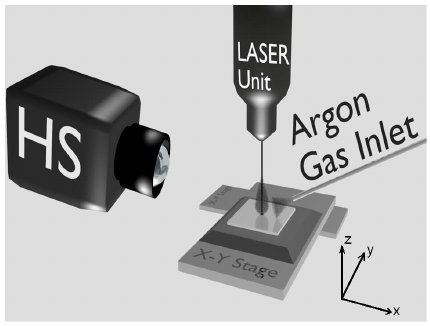
Figure 1. Schematic of experimental set-up for laser welding and monitoring. HS: High-speed camera. In order to protect the weld pool against oxidation, high-purity Argon (Ar, 99.9999%) was used as shielding gas. The Ar gas was delivered through a 4 mm diameter polytetrafluoroethylene (PTFE) tubing placed in the xz plane, at 3 cm from the laser spot at an angle of approximately 50° in respect to the sample surface, while the sample was translated along the y direction (see Figure 1 for movement reference). An optimized Ar flow rate of 5 L/min was used for preventing oxidation. Thus, an Ar content of 99% was measured 1 cm ahead of the welding site by mass spectrometry.